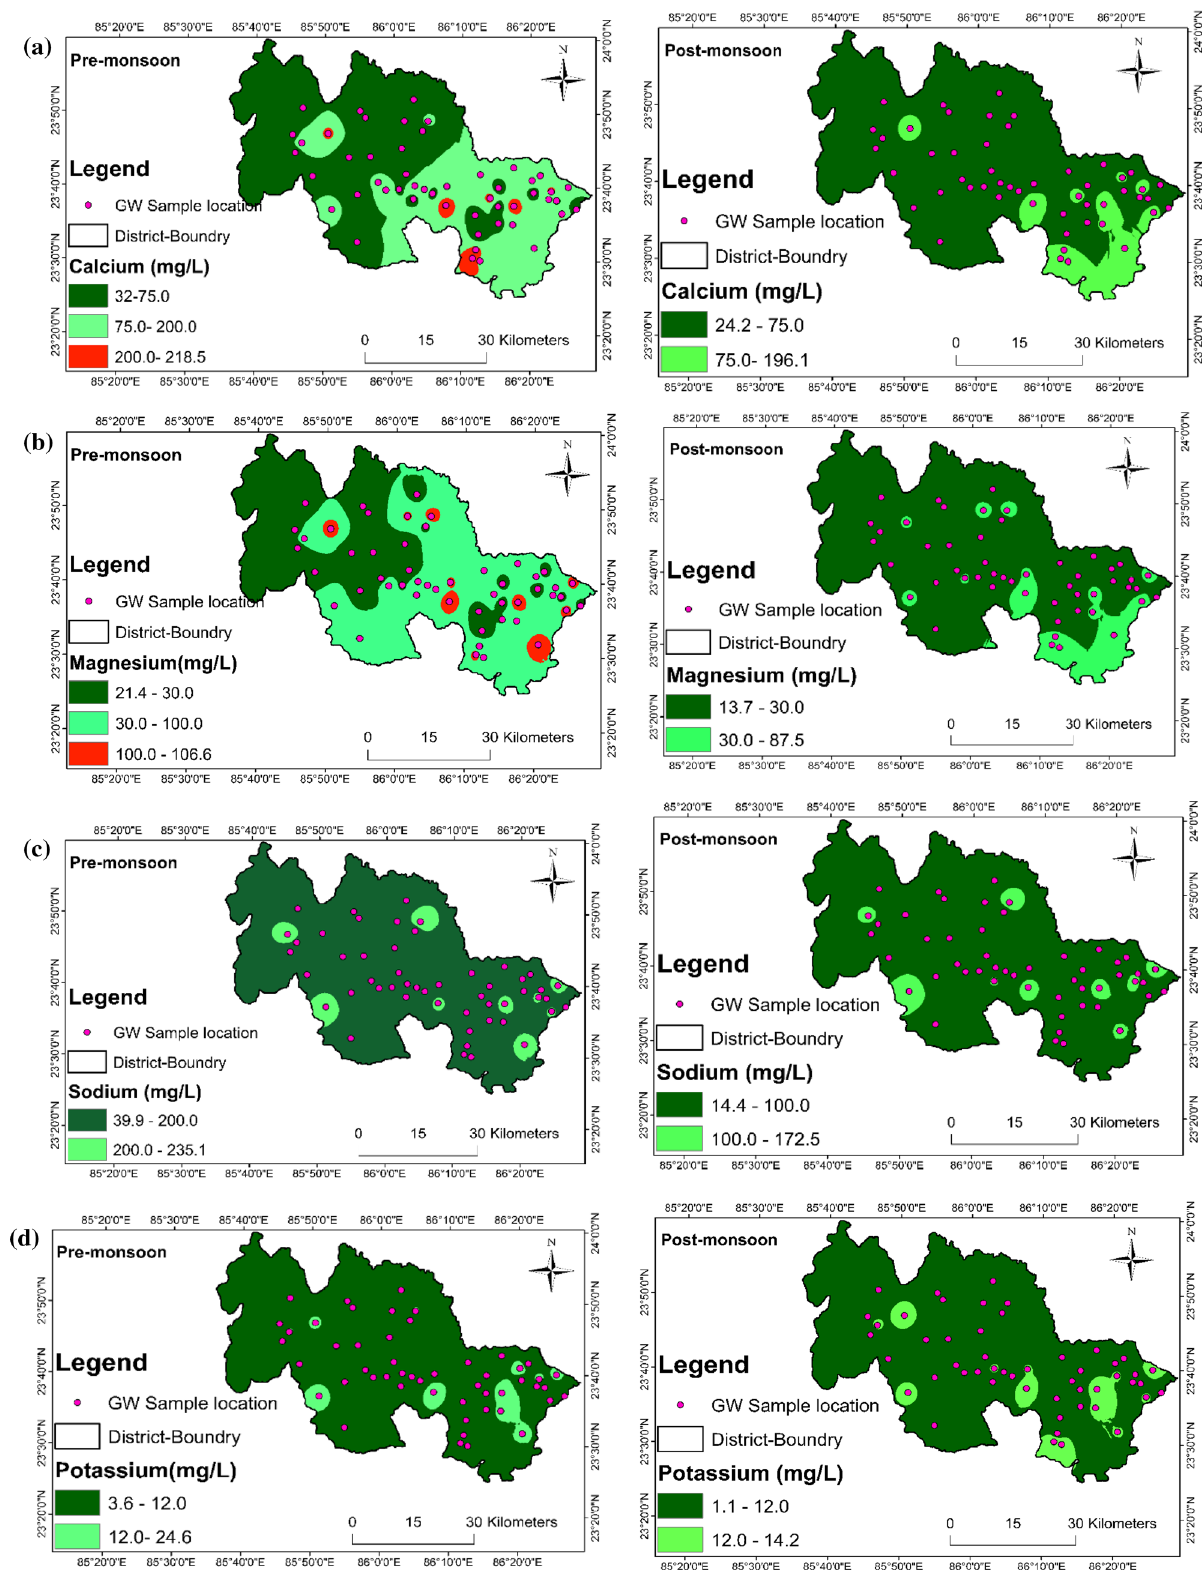
Fig. 4 Spatial variation in